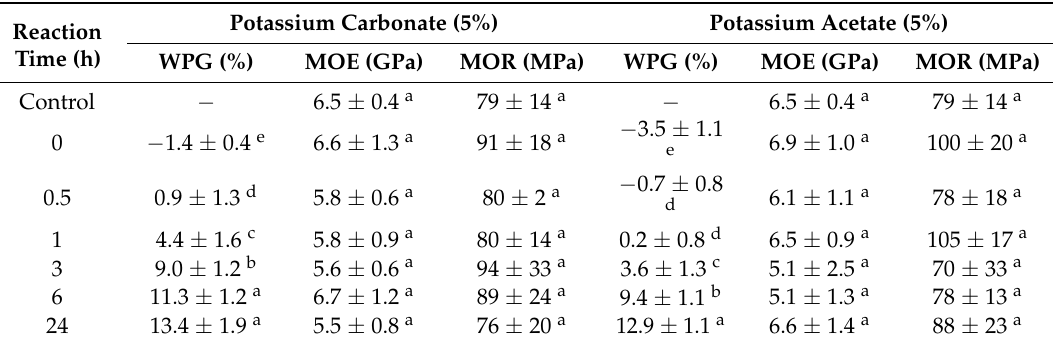
Table 1. The weight percent gain (WPG), modulus of elasticity (MOE), and modulus of rupture (MOR) of vinyl acetate (VA)-acetylated slicewood with two different catalysts by the reaction at 140 ◦ C for 0–24